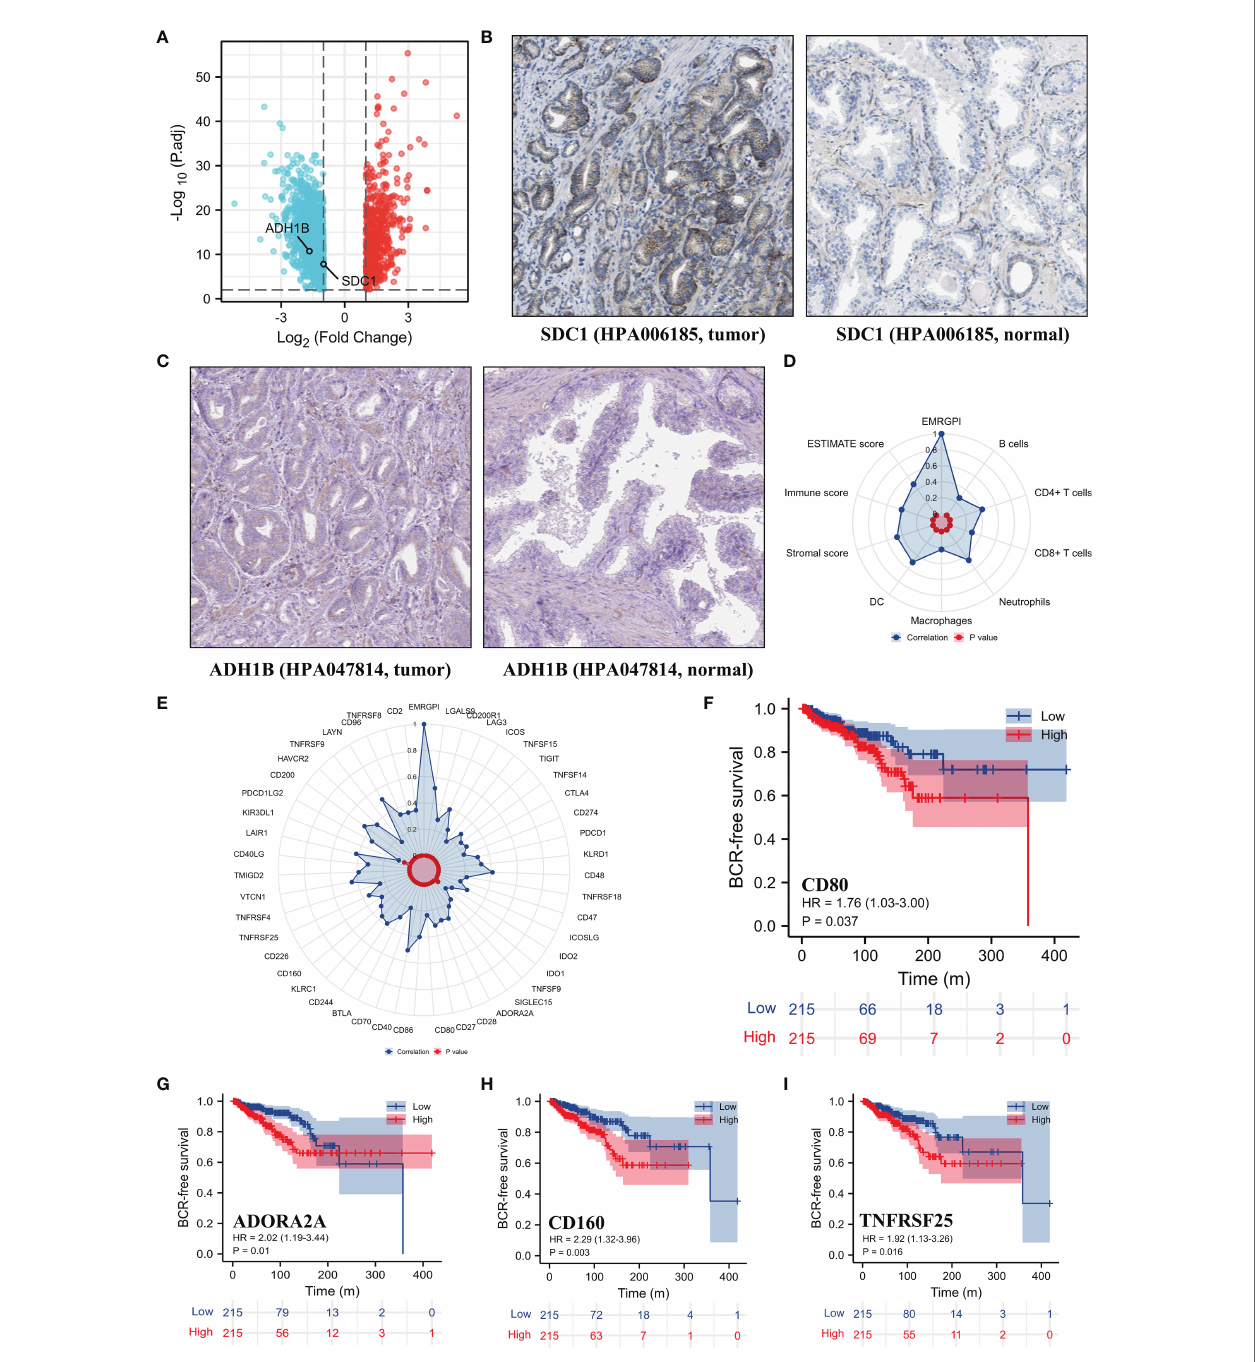
FIGURE 2 | Differential expression of SDC1 and ADH1B and TME analysis. (A) volcano plot showing differentially expressed genes between tumor and normal tissues; (B) differential expression of SDC1 at protein level in the HPA database (19, 20); (C) differential expression of ADH1B at protein level in the HPA database (19, 20); (D) the correlations between EMRGPI and TME indicators; (E) the correlations between EMRGPI and immune checkpoints; (F) Kaplan-Meier curve showing survival difference of high- and low-expression of CD80 in the TCGA database; (G) Kaplan-Meier curve showing survival difference of high- and low-expression of ADORA2A in the TCGA database; (H) Kaplan-Meier curve showing survival difference of high- and low-expression of CD160 in the TCGA database; (I) Kaplan-Meier curve showing survival difference of high- and low-expression of TNFRSF25 in the TCGA database. BCR, biochemical recurrence; EMRGPI, energy metabolism- related gene prognostic index; TME, tumor immune